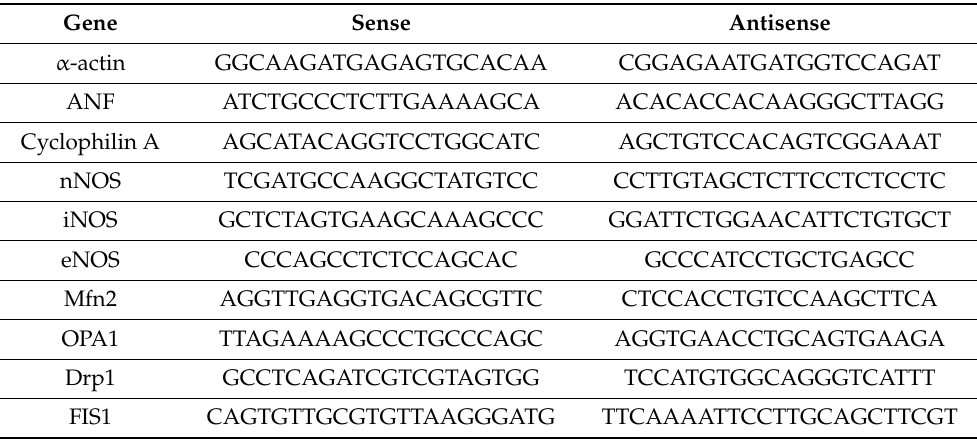
Table 1. List of the